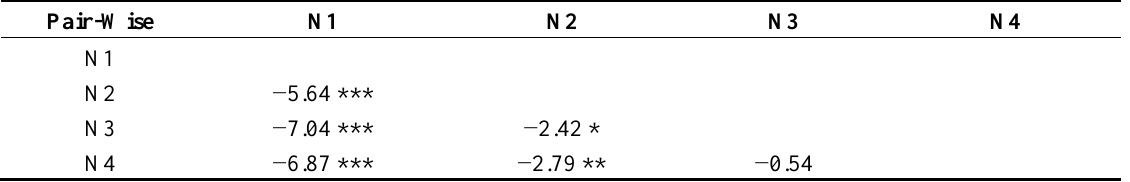
Table 12. Pair-wise Z statistic test of the comparisons of the different classification strategies in the northern study area.